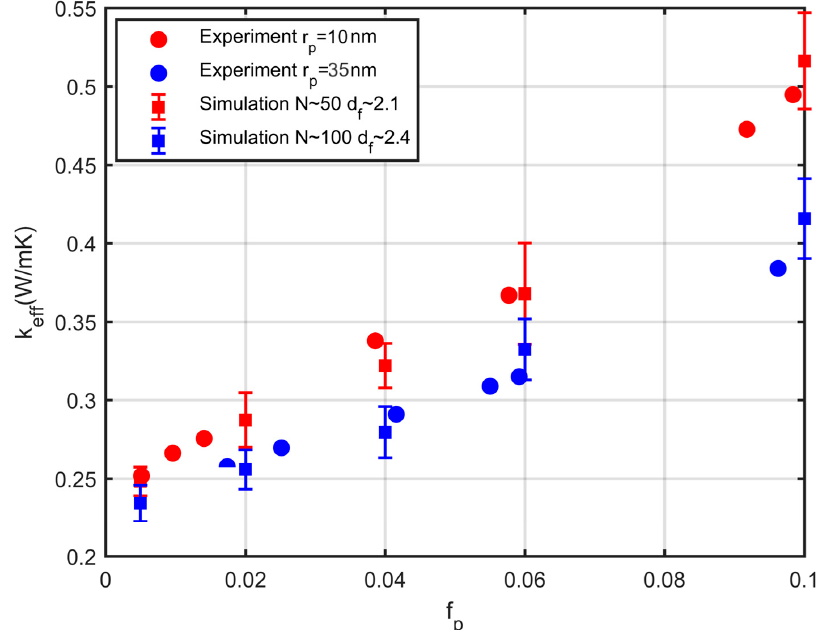
Figure 15. Comparison of experimental results [41] (dots) and simulation results (squares). Red dots, particles of radius r p = 10 nm, red squares, simulation of N ∼ 50 particles per aggregate and fractal dimension, d f ∼ 2.1, blue dots, particles of radius r p = 35 nm, blue squares, simulation of N ∼ 100 particles per aggregate and fractal dimension, d f ∼